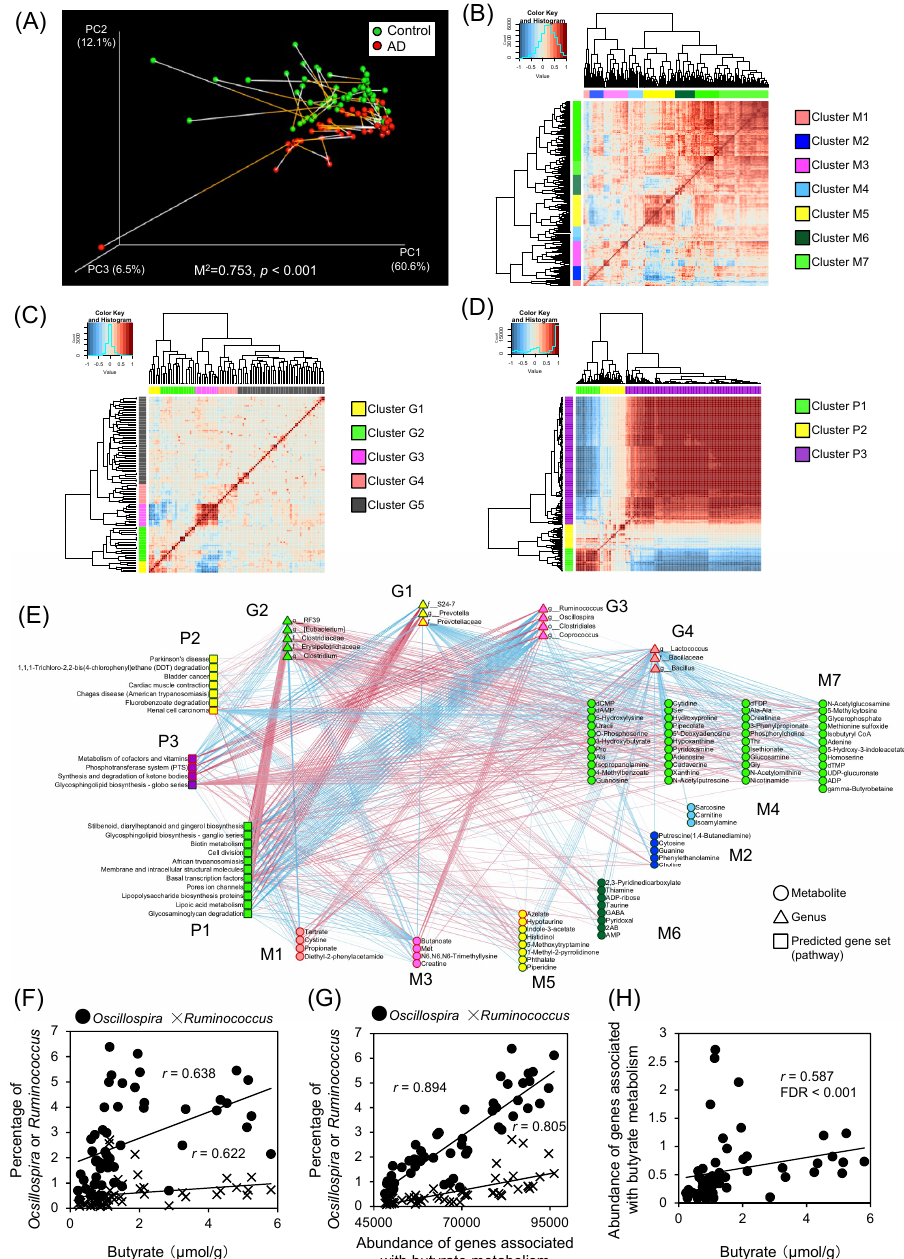
Figure 4. Metabologenomic approach reveals the interactions among abundances of microbial genus, predicted gene set, and metabolite concentration. ( A ) Procrustes analysis combining PCA of intestinal metabolome profiles (end of white line) and weighted UniFrac PCoA of microbiome profiles (end of orange line). The fit of Procrustes transformation over the first three dimensions is reported as the M 2 value; Autocorrelation maps of ( B ) metabolites, ( C ) bacterial genera, and ( D ) predicted bacterial gene sets (KEGG pathway) based on Spearman’s rank correlation coefficients. Red and blue indicate positive and negative correlation, respectively. Hierarchical clustering based on Euclidean distance was used to separate each metabolite/genus/gene set into clusters shown as side bars (to the right of the respective panels); ( E ) Bacterial genera, predicted gene sets, and metabolites that differed significantly between control and AD were assessed by network analysis. The pairs that yielded significant correlation between each bacterial genus, predicted gene set, and metabolites based on Spearman’s rank correlation coefficients (FDR < 0.05) are portrayed in this network graph. Node shapes denote the type of dataset (circle, metabolites; triangle, genera; square, predicted gene set). Green